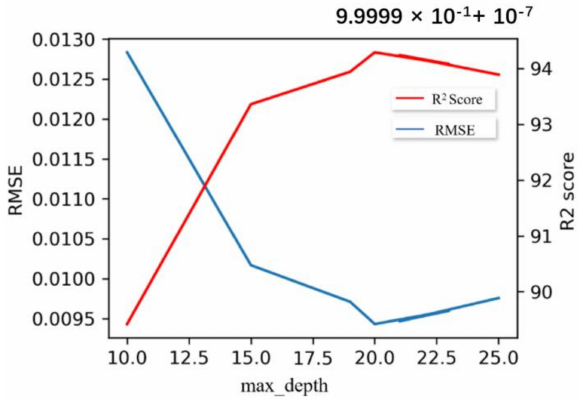
Figure 2. max_depth adjustment